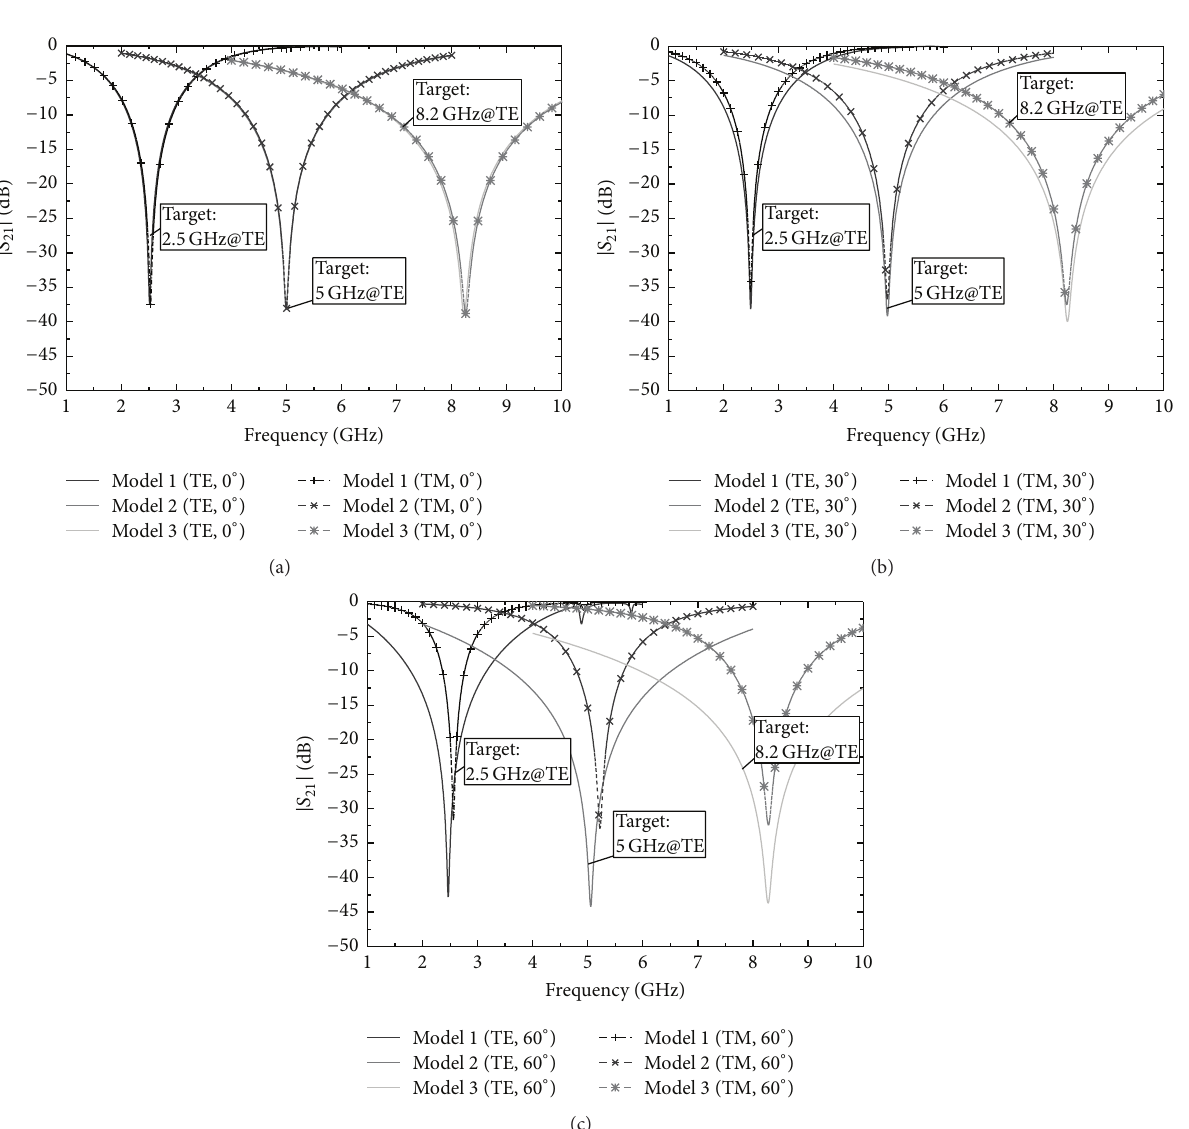
Figure 3: Simulated transmission characteristics of the proposed FSSs: (a) normal incidence, 0 ∘ , (b) 30 ∘ angle of incidence, and (c) 60 ∘ angle of incidence.